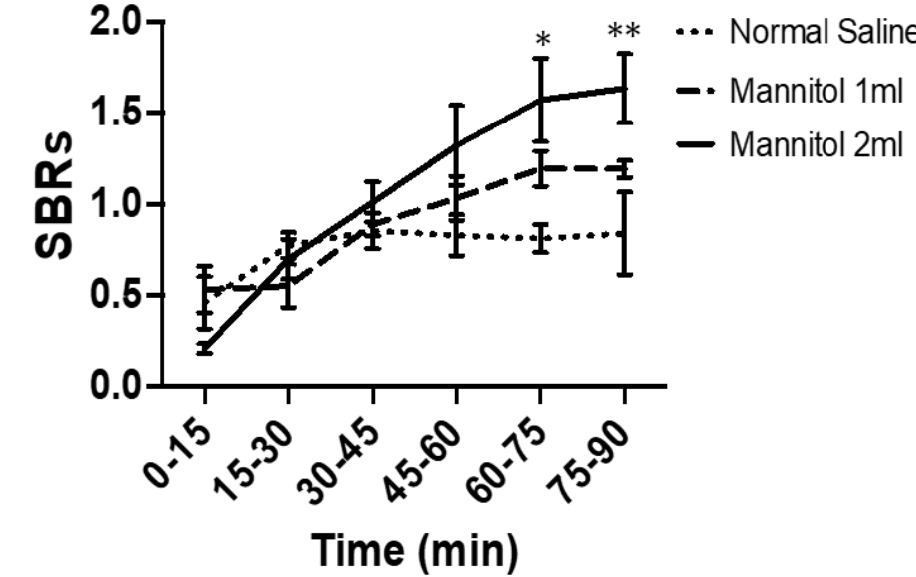
Figure 2. In vivo NanoSPECT/CT dynamic and static images of [ 99m Tc]Tc TRODAT-1, the striatal dynamic specific binding ratios (SBRs)during 0–90 min post- [ 99m Tc]Tc TRODAT-1 injection in normal saline, 1 mL, and 2 mL 20% mannitol pre-treated rats. (* p value < 0.05, ** p value < 0.01 compared to normal saline group).